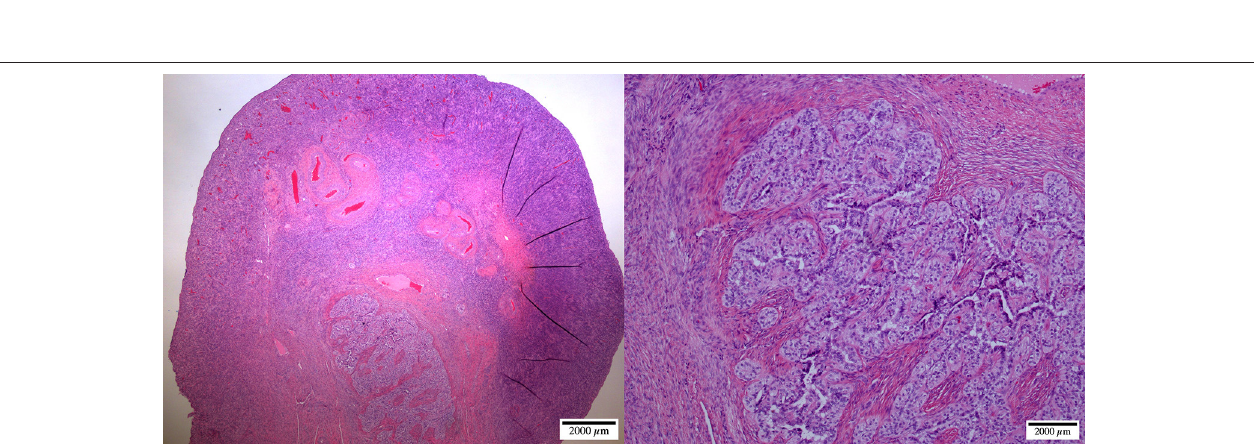
FIGURE 7 | Ovarian dysgenesis: micrographs at lower (left, × 20) and higher (right, × 100) magnification of the ovary-like structure. The cortex is undifferentiated, compact, and devoid of any follicular activity. The medulla shows a network of undifferentiated ducts [reclassified as ovarian dysplasia according to (26)].